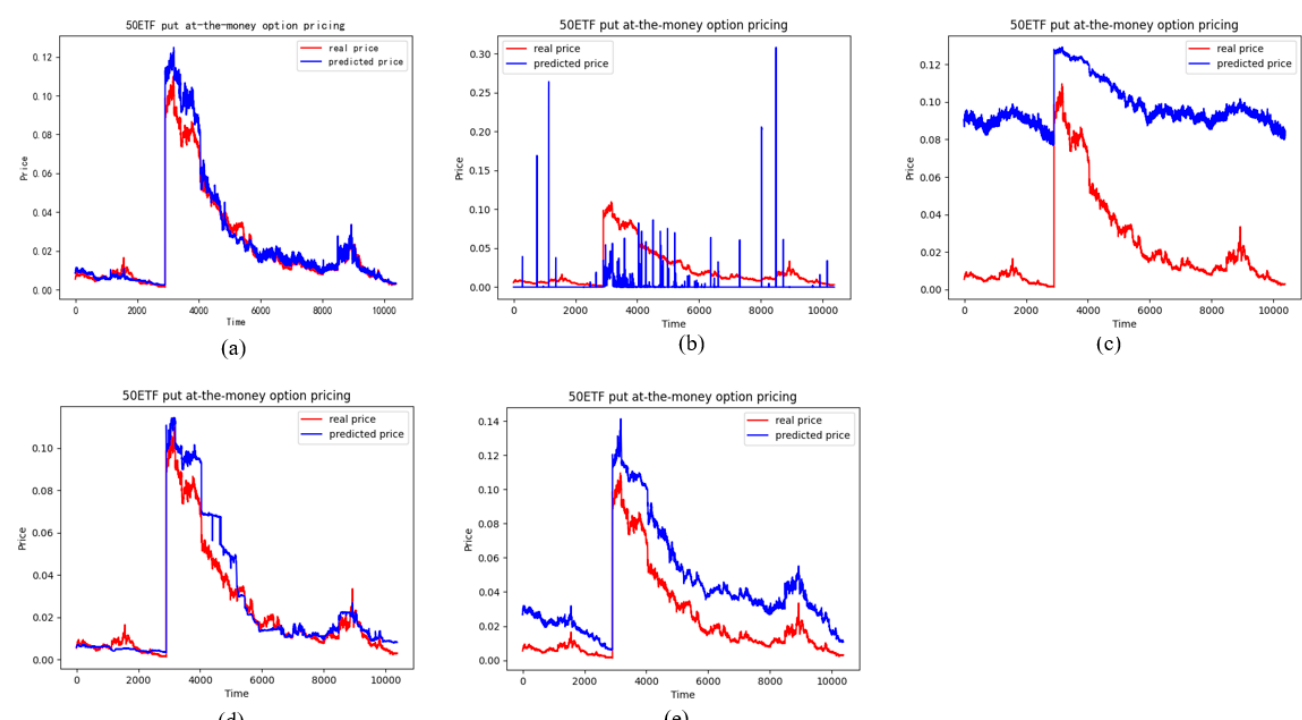
Figure 17. The pricing performance of ATM put options on each model ( a ) stands for the LSTM model, ( b ) stands for the BS model, ( c ) stands for the SVM model, ( d ) stands for the Random forests model, ( e ) stands for the RNN model.